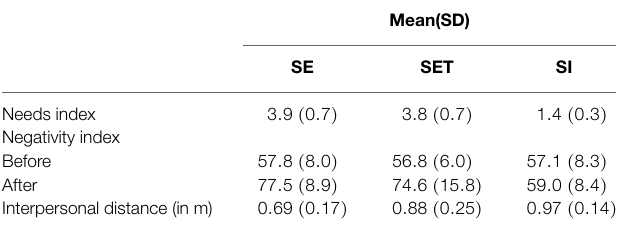
TABLE 1 | Needs index, negativity index (before and after cyberball) and preferred interpersonal distance contrasting the different conditions ( N = 69 total; N = 24; SE, social exclusion; N = 23; SET, social exclusion, technical failure; N = 22; SI, social inclusion).